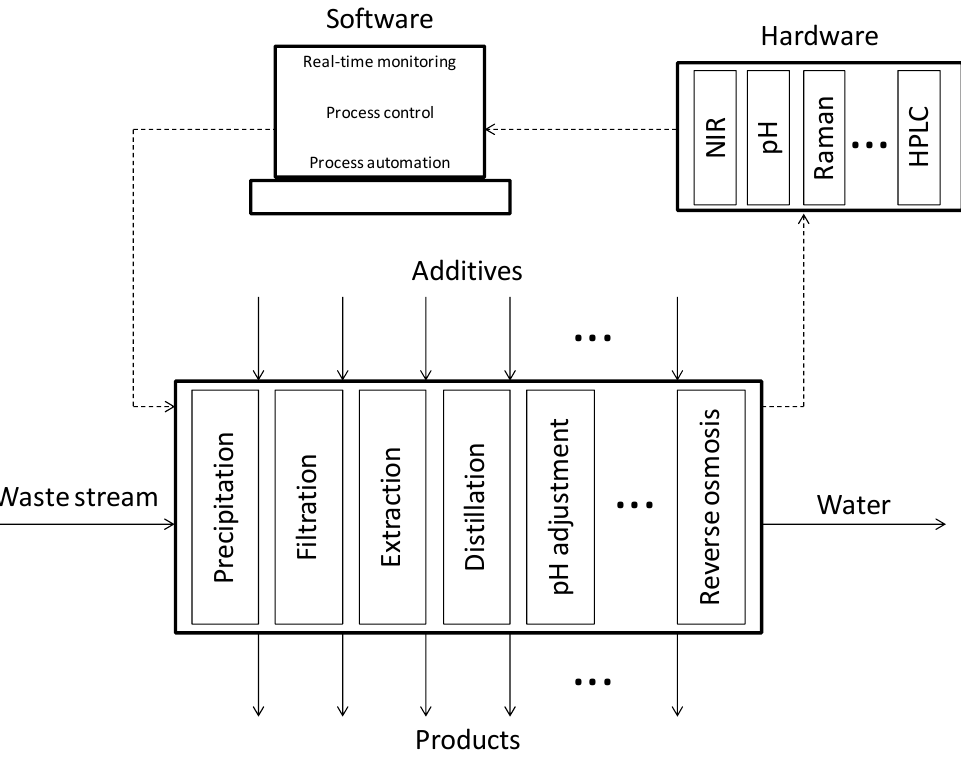
Figure 4. Schematic representation of the concept for improving reactor productivity and for the “plug ‐ and ‐ play” approach for integrated process design aiming at achieving a zero ‐ waste policy.